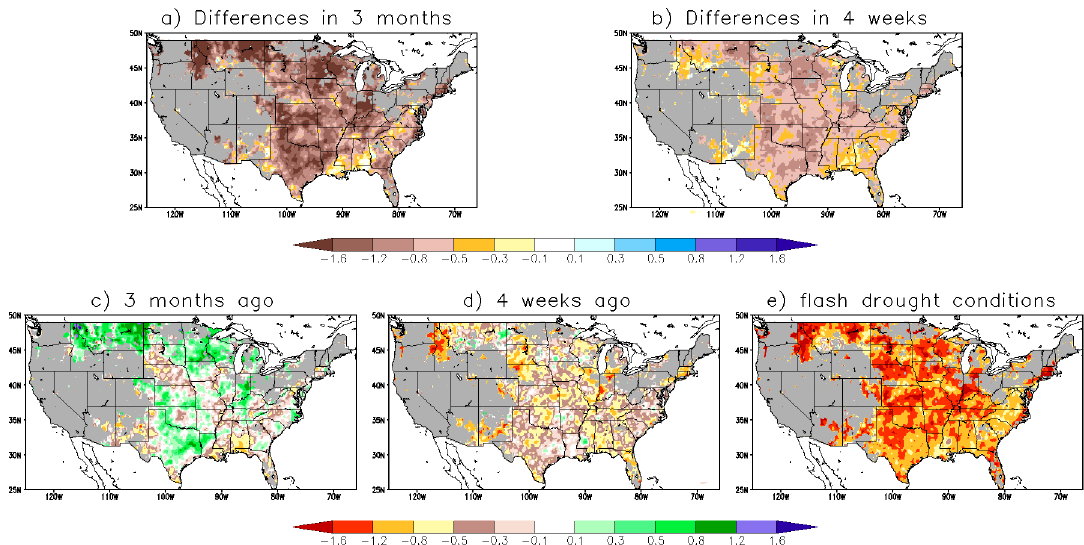
Figure 10. Composites of three-month Standardized Precipitation Index for ( a ) differences between flash drought conditions and the conditions three months ago, ( b ) differences between flash drought conditions and the conditions four weeks ago, ( c ) the conditions three months before drought onset, ( d ) the conditions four weeks before drought onset, and ( e ) the conditions under flash drought onset. Areas with less than 1% flash drought occurrence are shown in grey.